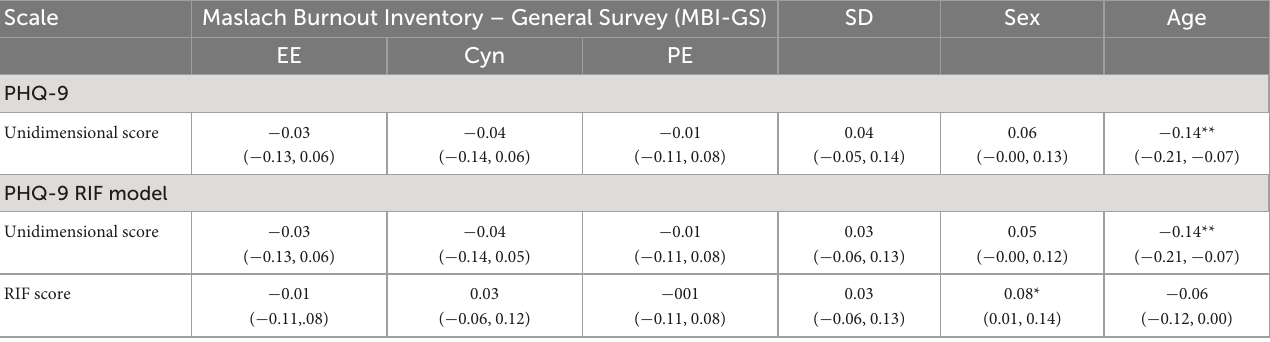
TABLE 7 Association with external variables: Unidimensional and RIF score model. Scale Maslach Burnout Inventory – General Survey